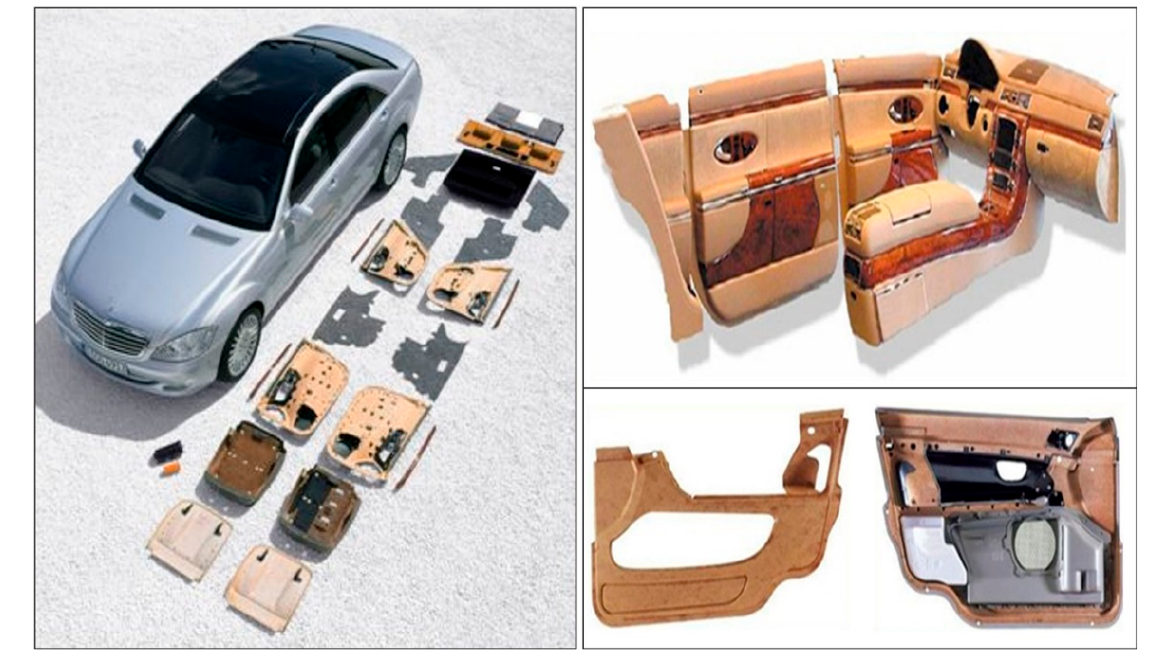
Figure 5. Automobile components made from NFRCs [176]. Reprinted with permission. Copyright 2015 SciELO Brasil.